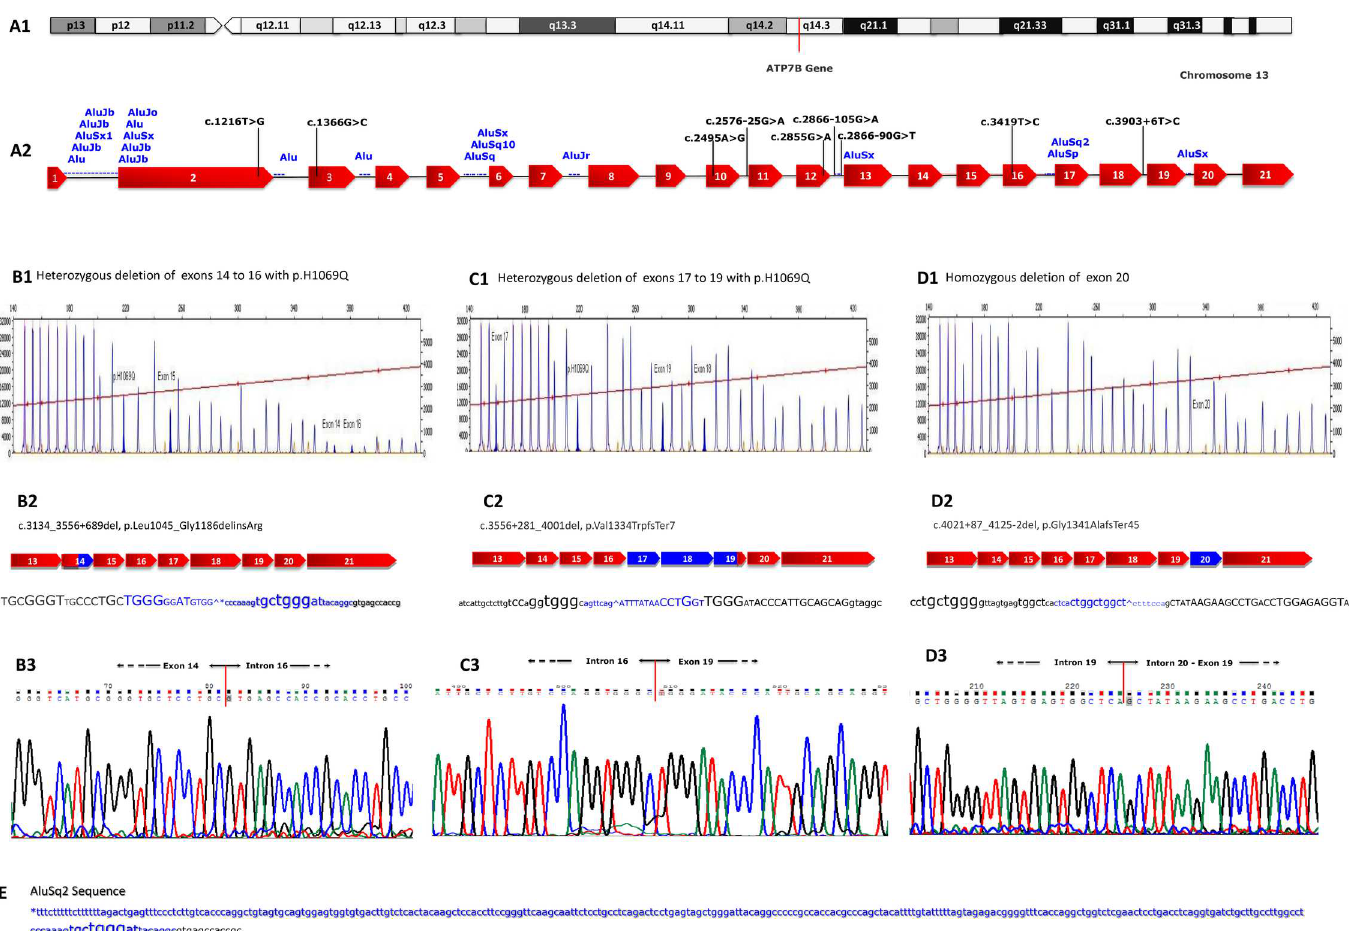
Fig 1. Molecular characterization and breakpoint analysis of large intragenic deletions in the ATP7B gene. A1. Schematic illustration of locus q14.3 on chromosome 13. A2. Diagrammatic representation of ATP7B with SNP profile indicatedby vertical bars in ATP7B gene, the red colored boxes in the genomicsequencerepresent exons (1–21), Alu content of the ATP7B is depictedin blue and SNP in black. B1, C1 and D1. Multiplexligation-dependent probe amplification gene dosageassay for exons 14 to 16 deletion,exons 17 to 19 and exon 20 respectively. B2, C2 and D2. Schematic representation of the deletionin gene, the blue boxes are the exon regions deletedand the blue nucleotides indicate the deletedfragments. Capitalletters representexon sequences.Asterisk indicatesthe location of the AluSq2 elementin 3 0 end of the deletedfragment. B3, C3 and D3. Nucleotidesequenceand electropherogram at the breakpoints of the aberrantfragments representing flanking regions of the detected intragenicdeletionsare shown. E. Enlarged nucleotides highlightconsensussequencesnear the breakpoints (homologous sequences,elementswith internalsymmetry and palindromes) as potential hot spots for